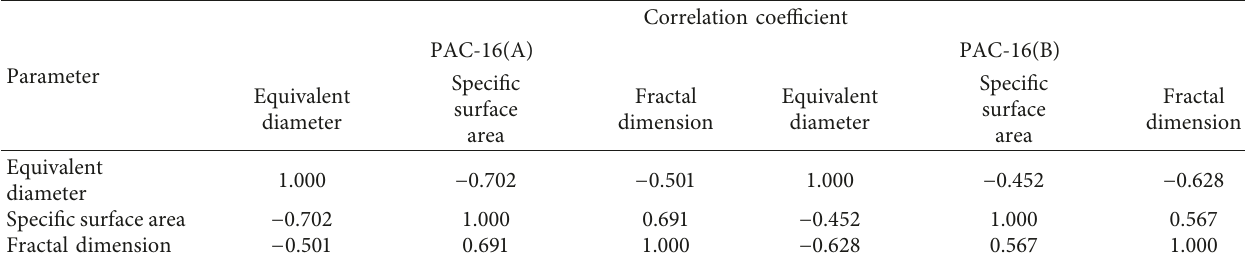
Figure 7: Vertical AV dimension in PA specimens with AV contents of 16% and 20%, respectively: (a) equivalent diameter, (b) specific surface area, and (c) fractal dimension. Table 5: Correlations among the three-dimensional